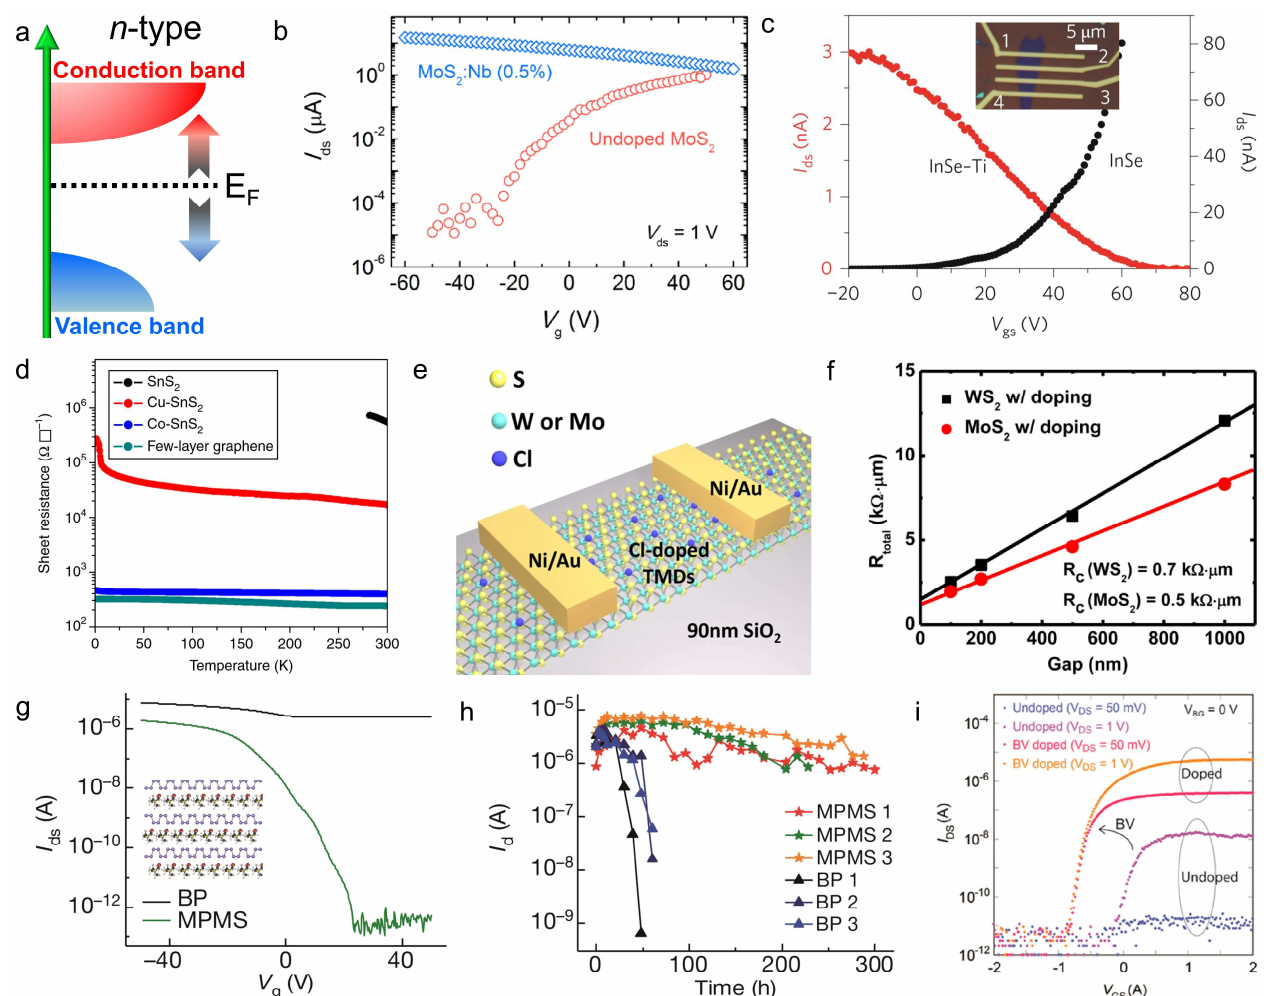
Figure 6. Regulating electrical properties of 2DMs by doping. ( a ) N-type doped band structure diagram. ( b ) Typical electrical transport characteristics of Nb and undoped MoS 2 devices. Repro- duced with permission from [84]. ( c ) Field effect measurements of the InSe before and after the Ti treatment. Reproduced with permission from [75]. ( d ) R-T curves of SnS 2 , Cu-SnS 2 , Co-SnS 2 , and graphene. Reproduced with permission from [53]. ( e ) Schematic diagram of Cl-doped few-layer WS 2 back-gate FET. ( f ) Transfer length method resistances of Cl-doped WS 2 and MoS 2 . Reproduced with permission from [61]. ( g ) The on/off ratio measurement of the same BP before and after intercalation. ( h ) Electrical stability of three MPMS and three BP devices with similar starting on-current. Repro- duced with permission from [79]. ( i ) Transfer characteristic curves of the top-gate device before and after BV treatment. Reproduced with permission from [105].